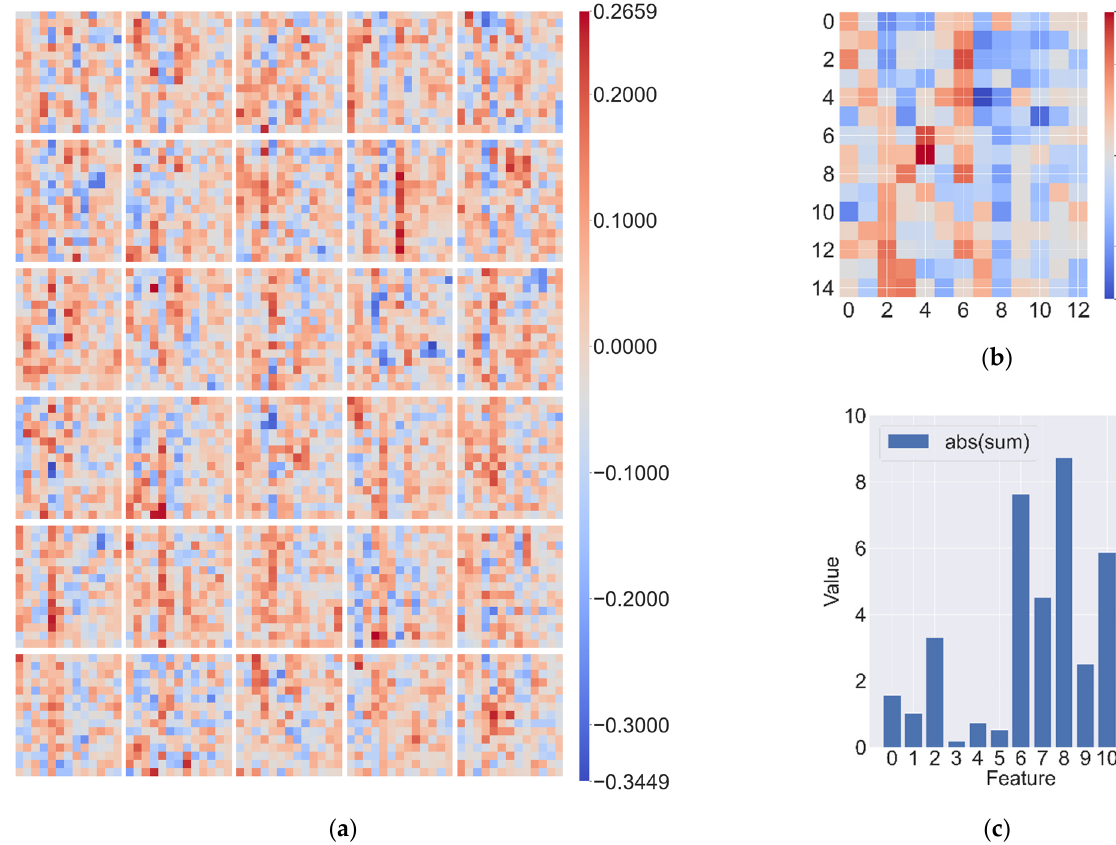
Figure 22. ( a ) Convolution kernel of the Conv_1; ( b ) Results of convolution kernel summation (matrix Q); ( c ) Sum Q by columns and take the absolute value.